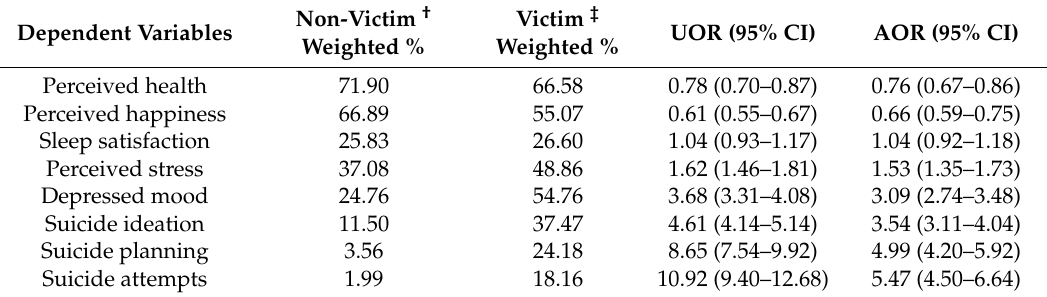
Associations between violence victimization and psychological problems among Korean